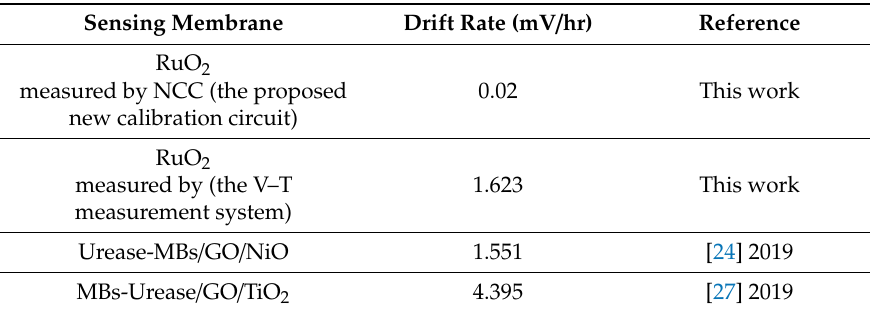
Table 3. Comparison of drift rates of urea biosensor with di ff erent sensing membranes.